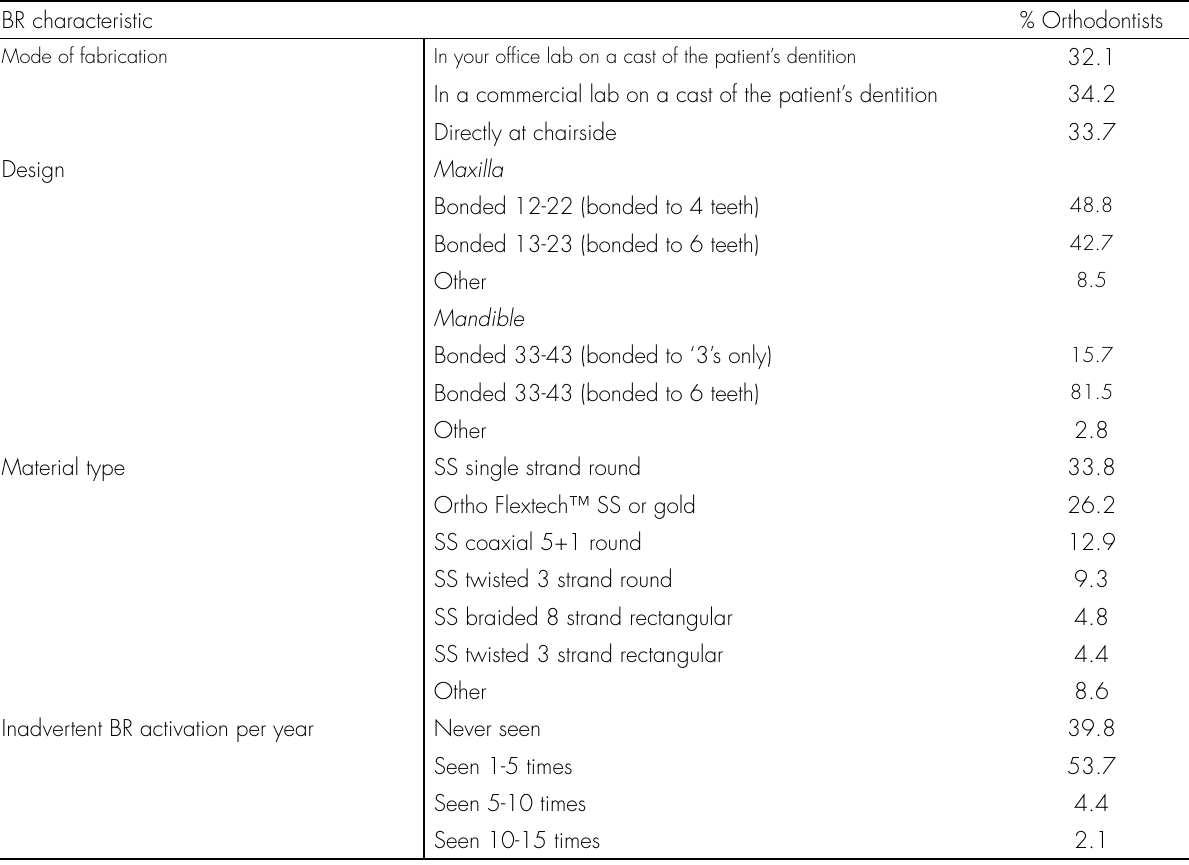
Table VIII. Overview of bonded retainer characteristics by orthodontists.